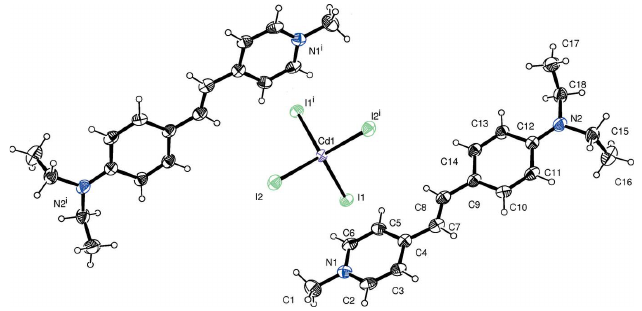
Figure 1 A view of the molecular structure of salt (I), with the atom labelling. Displacement ellipsoids drawn at the 30% probability level. [symmetry code: (i) (cid:3) x , y , (cid:3) z + 1 .] 2